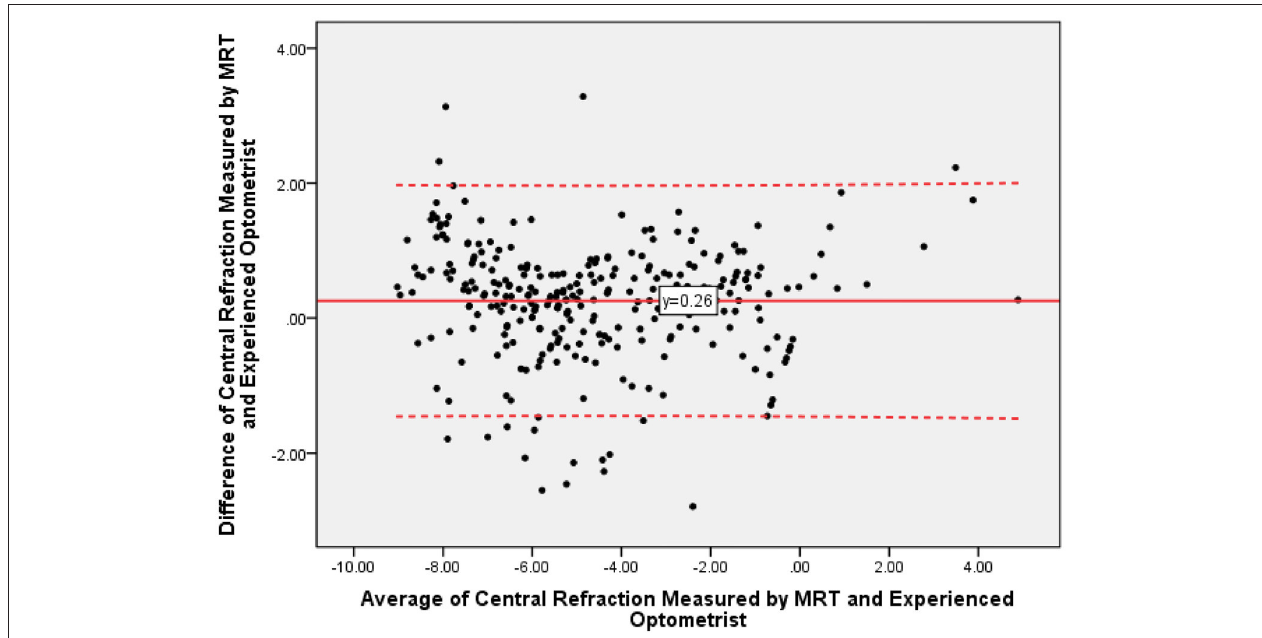
FIGURE 3 | The Bland-Altman plots of central refraction obtained by MRT and experienced optometrist.